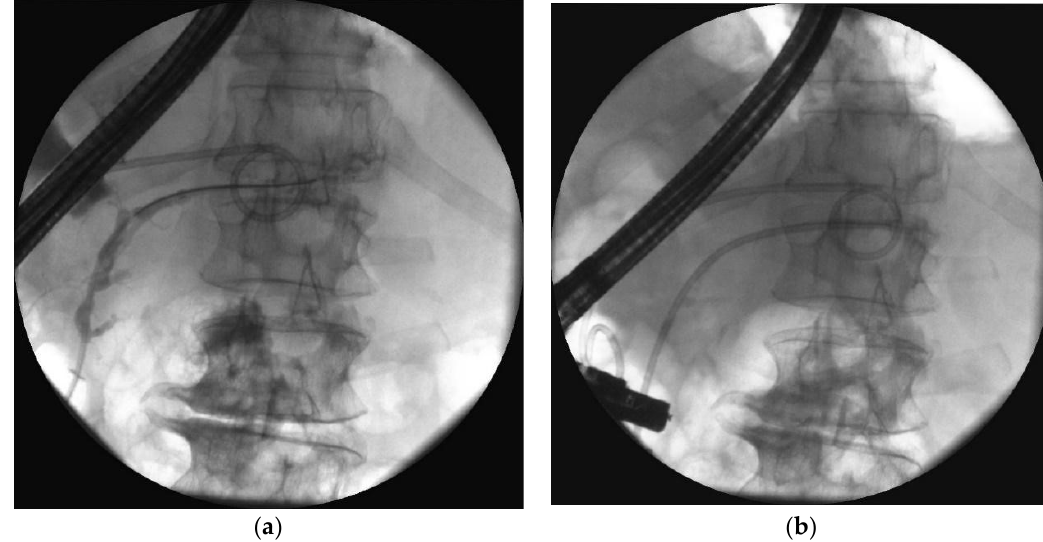
Figure 8. ERP during endoscopic treatment of pancreatic necrosis. ( a ) Complete disruption of the pancreatic duct can be seen within the tail at the level of transmural stent. ( b ) The stent bridging the pancreatic duct disruption. ERP, endoscopic retrograde pancreatography.